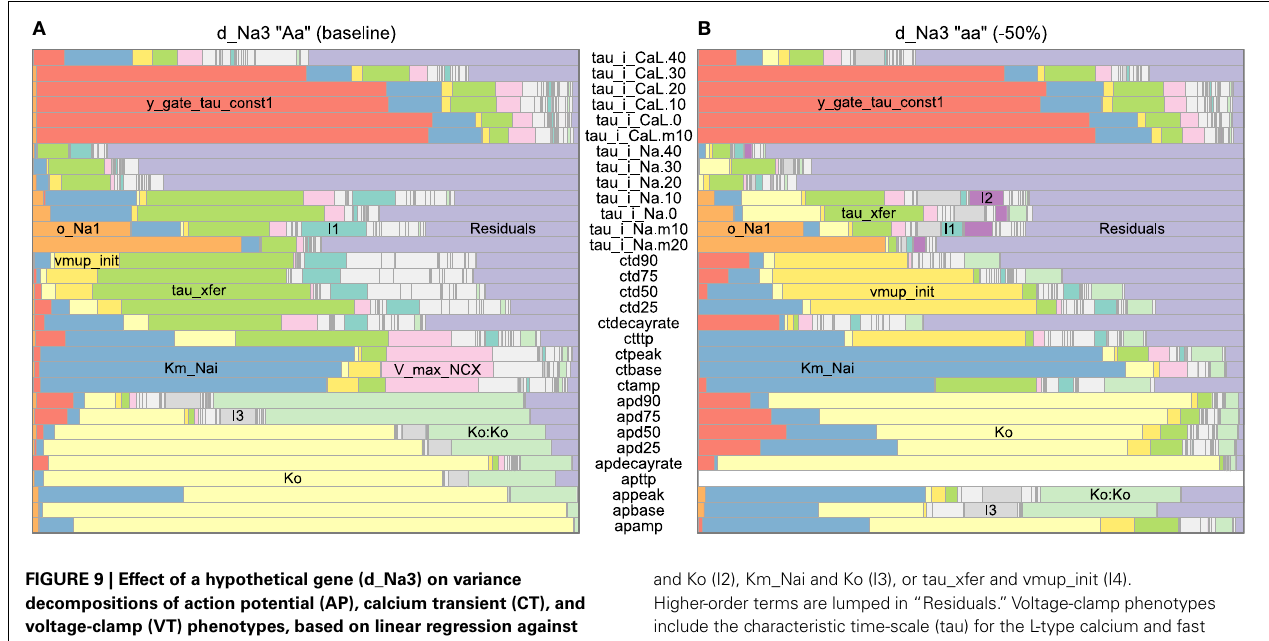
FIGURE 9 | Effect of a hypothetical gene (d_Na3) on variance decompositions of action potential (AP), calcium transient (CT), and voltage-clamp (VT) phenotypes, based on linear regression against genotypic parameters including second-order and quadratic terms to capture genetic interactions and intralocus non-additivity. Simulated genes with large variance components are labeled; Ko:Ko denotes the quadratic term for Ko. Second-order interactions were minor in this case except those of tau_xfer and Km_Nai (labeled I1), tau_xfer